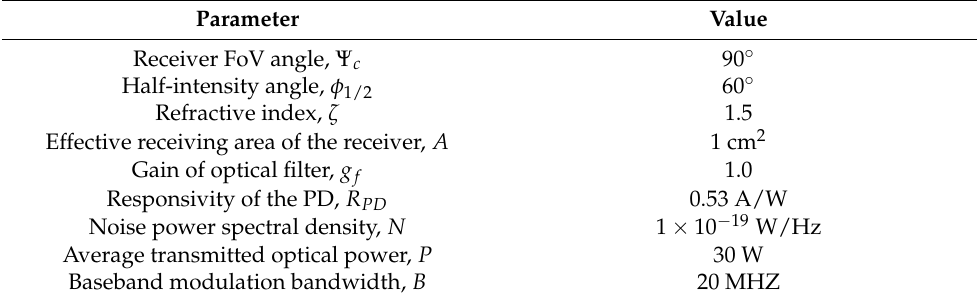
Table 4. Simulation parameters related to VLC